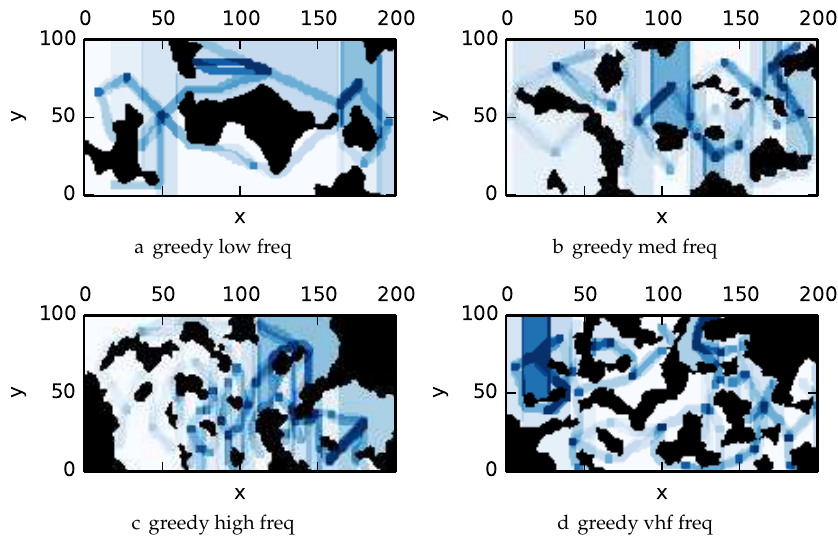
Figure 12. Multipass coverage plans in environments with uniform information for the greedy heuristic